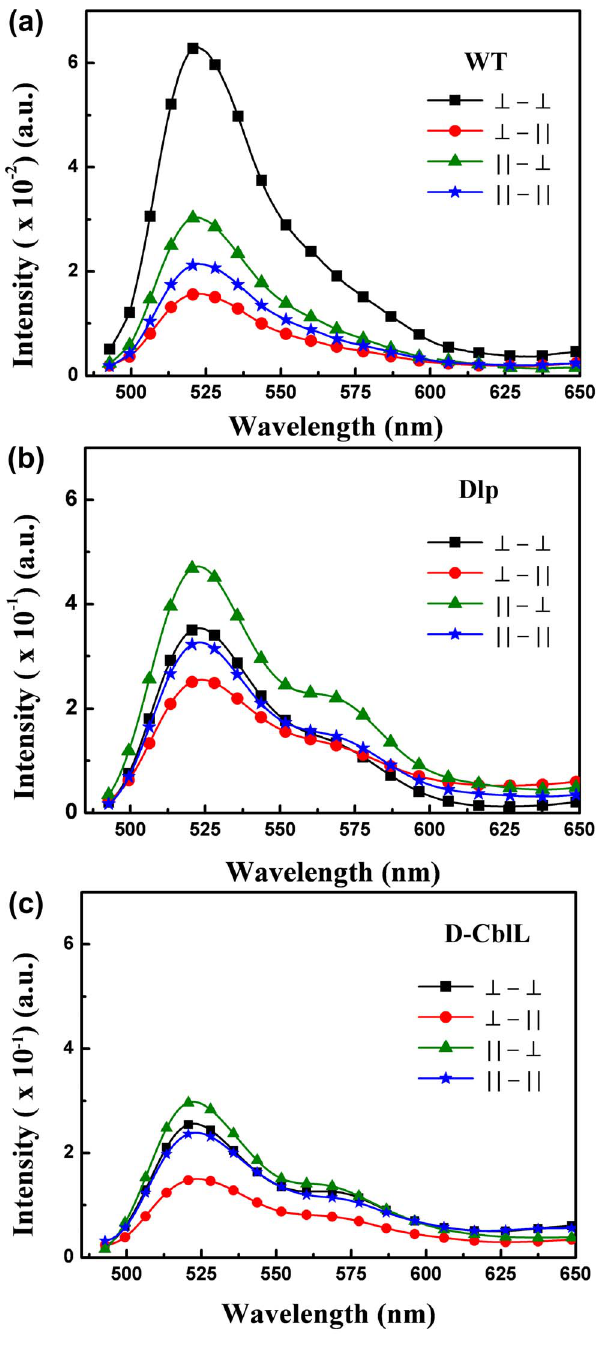
Figure 2. The polarized photo-induced fluorescence spectra showing the global distribution of the Gurken gradient in stage 10A egg chambers for (a) wild-type, (b) overexpressing Dlp, and (c) overexpress- ing D-CblL after linear background subtraction. The experimental data were contingent on linear polarization by vertical and horizontal